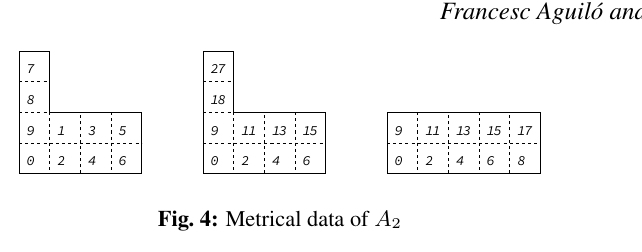
Fig. 4: Metrical data of A